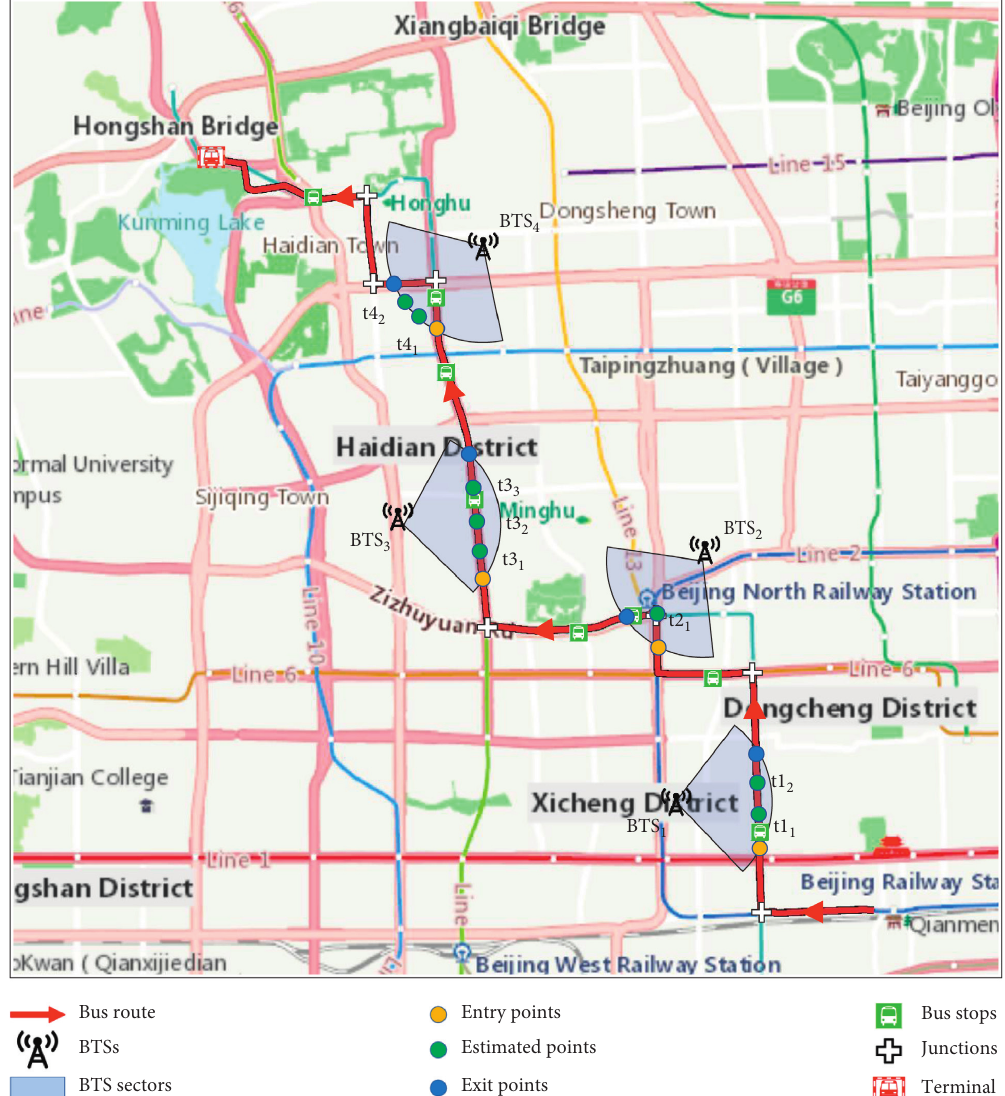
Figure 11: Diagram of BTS coverage and LCSS